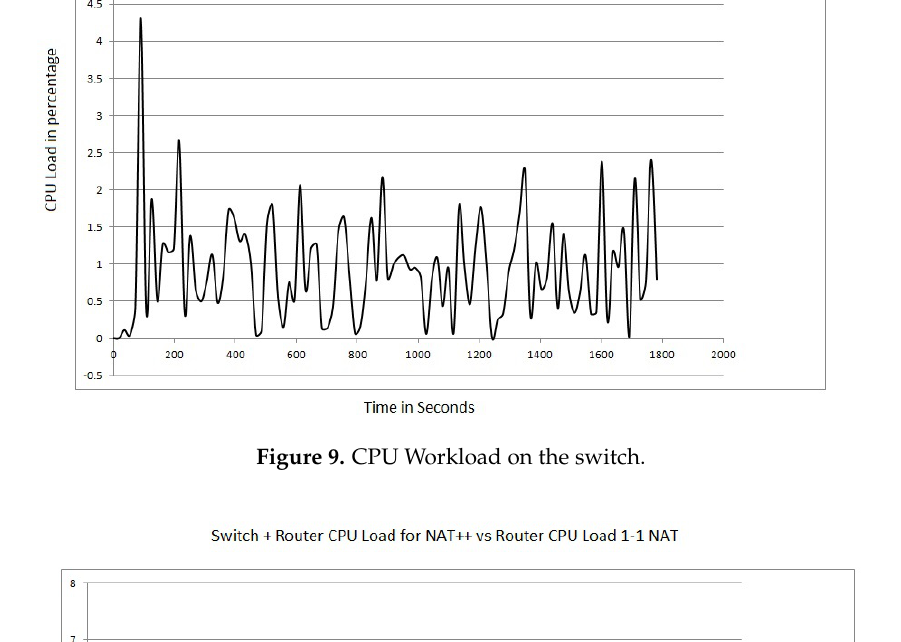
Figure 9. CPU Workload on the switch.